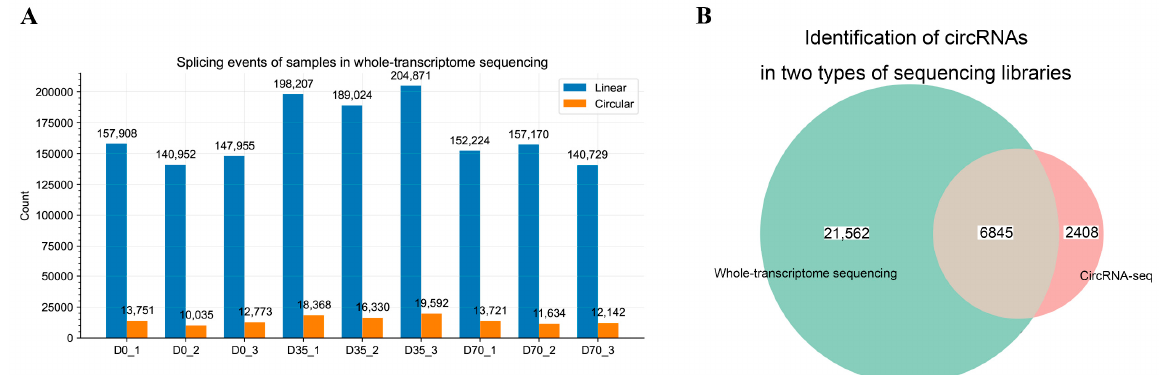
Figure 2. Identification of circRNAs in skeletal muscle tissues at three growth stages of rabbits. ( A ) Splicing events were detected in each skeletal muscle tissue by whole-transcriptome sequencing. ( B ) The Venn diagram of circRNAs from whole-transcriptome sequencing libraries and circRNA- seq library.